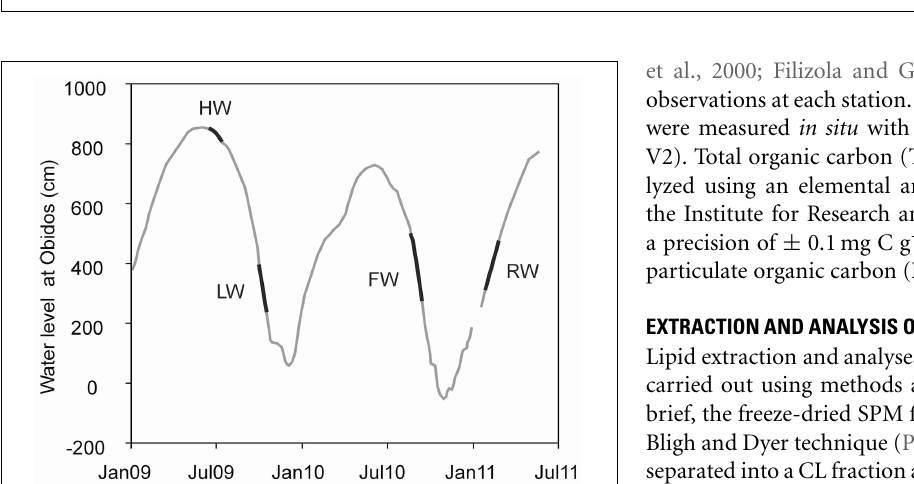
FIGURE 2 | Study area (A) showing the sampling stations along the Amazon main stem and its tributaries (B). Note that A1–A4 indicate sampling stations Amazon 1–4.